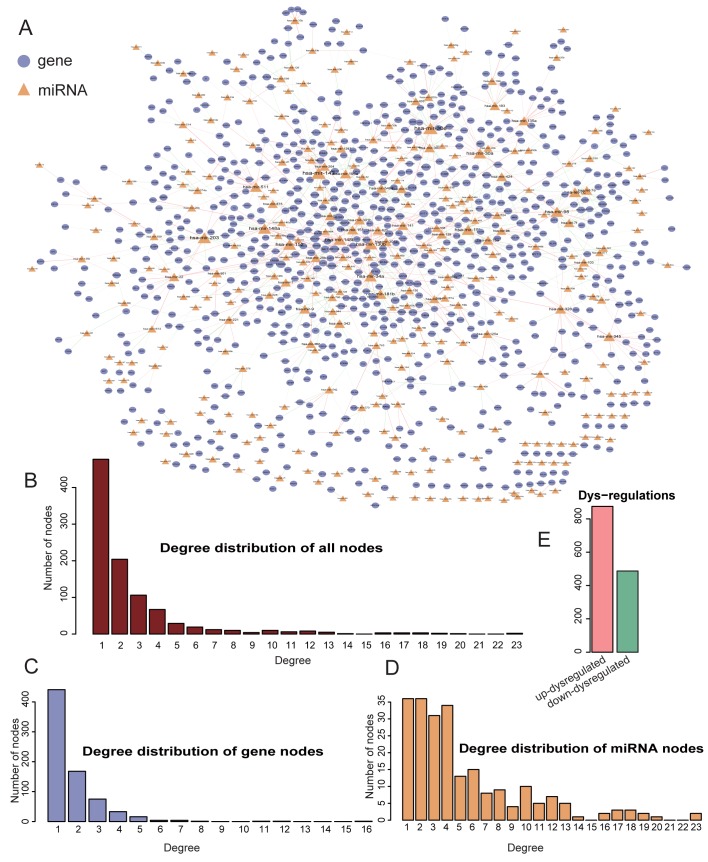
Topological features of the micro (mi)RNA-target gene differential regulatory network (MGDRN).A.Overview of the MGDRN; the purple and orange nodes represent mRNAs and miRNAs, respectively. The size of nodes represents the degrees of nodes in the network. The blue and pink edges in the MGDRM represent down-dysregulation and up-dysregulation involving tumor versus normal conditions, respectively. B. The node distribution of all nodes in the MGDRN. C. The node distribution of all mRNAs. D. The node distribution of all miRNAs. E. The number of down-dysregulated and up-dysregulated relationships in the MGDRN.